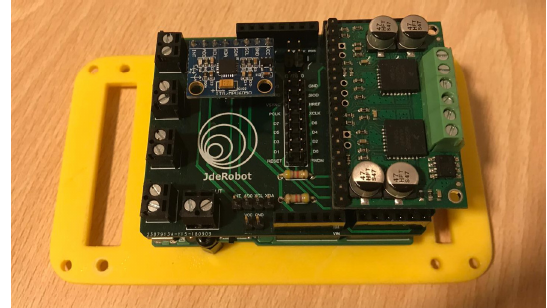
Figure 19. Final system with physical components assembled.